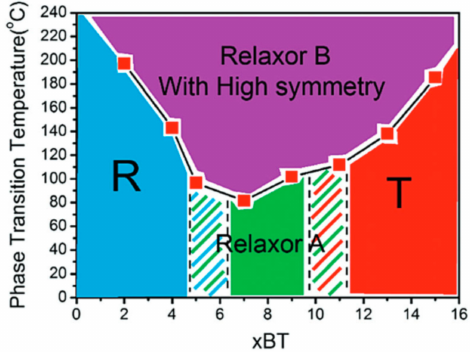
Figure 1. Phase diagram of (1 − x )Bi 0.53 Na 0.47 TiO 3 – x BaTiO 3 (BNT– x BT) by Zhou et al. Reproduced from Ref. [20] with permission from the PCCP Owner